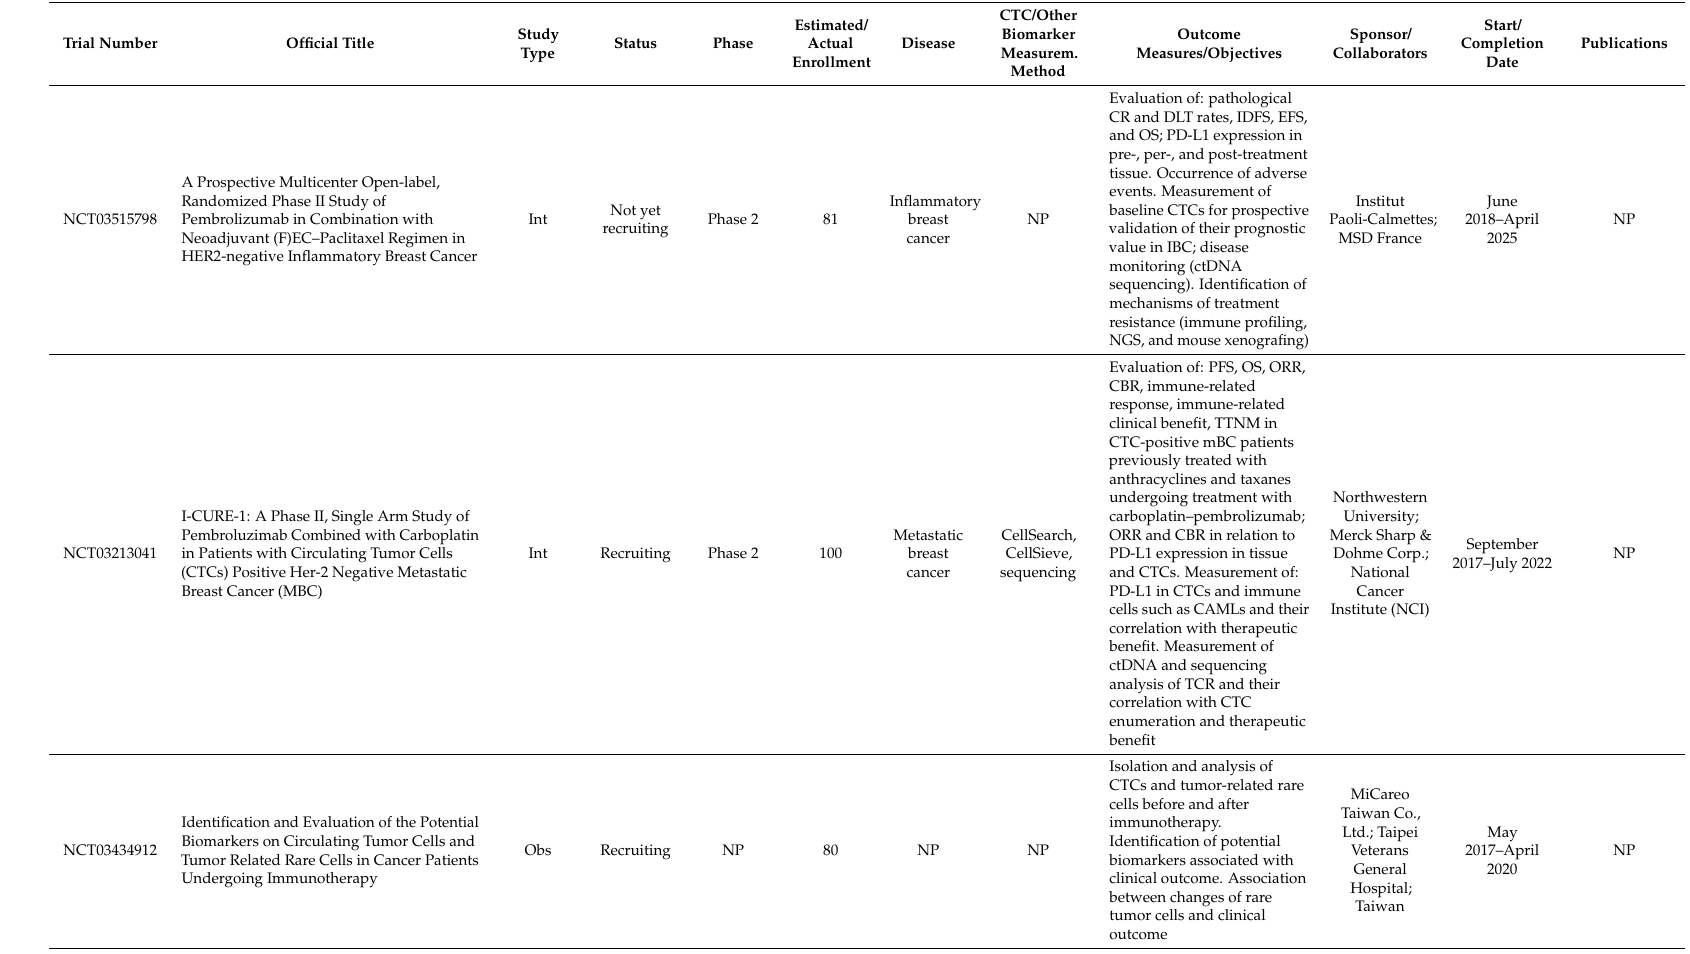
Table 1. List of clinical trials where CTCs are being/have been investigated in patients undergoing cancer immunotherapies. The list is based on the ClinicalTrials.gov database as of August